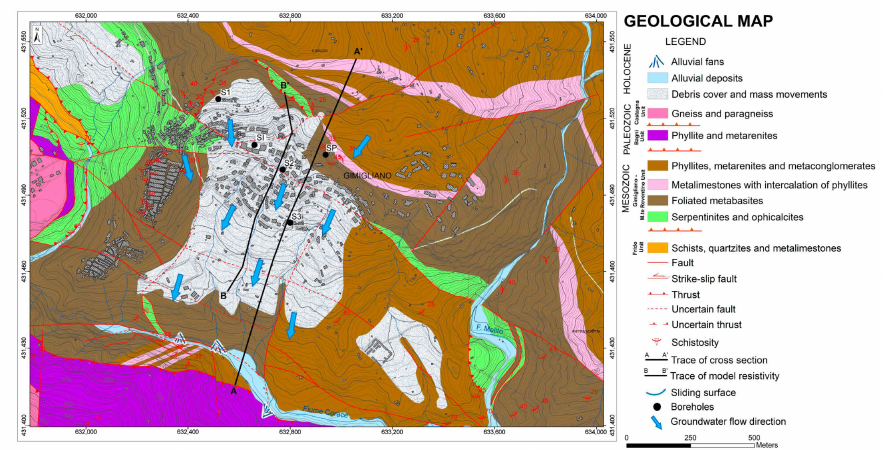
Figure 3. Detailed geological map of the Corace River-Gimigliano village area. A-A’ is the geological cross-section trace. In the central sector (white color), the landslide and slope deposits are